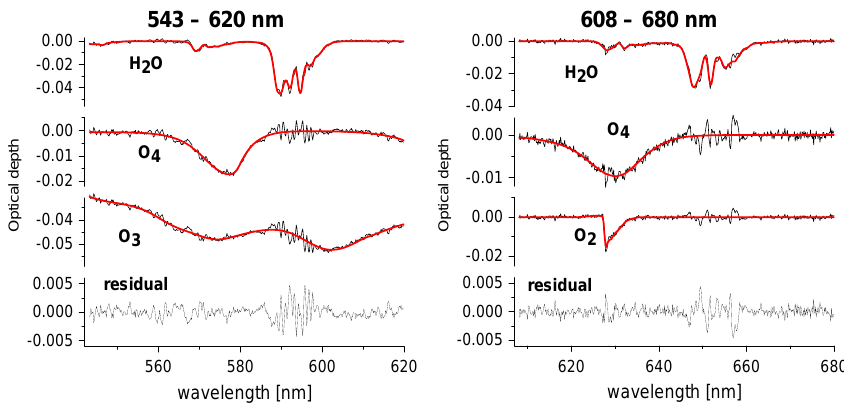
Fig. 2 Typical result of the DOAS fit in both spectral windows. Shown are the cross-sections (red) scaled to the respective absorption in the measured spectrum (black). Observations are from 4 April 2011, 8:30 for an elevation angle of 20° and a solar zenith angle of 58.0°.